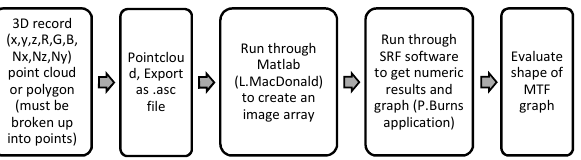
Figure 18. Process 2: Evaluation pathway for spatial resolution evaluation for 3D images.